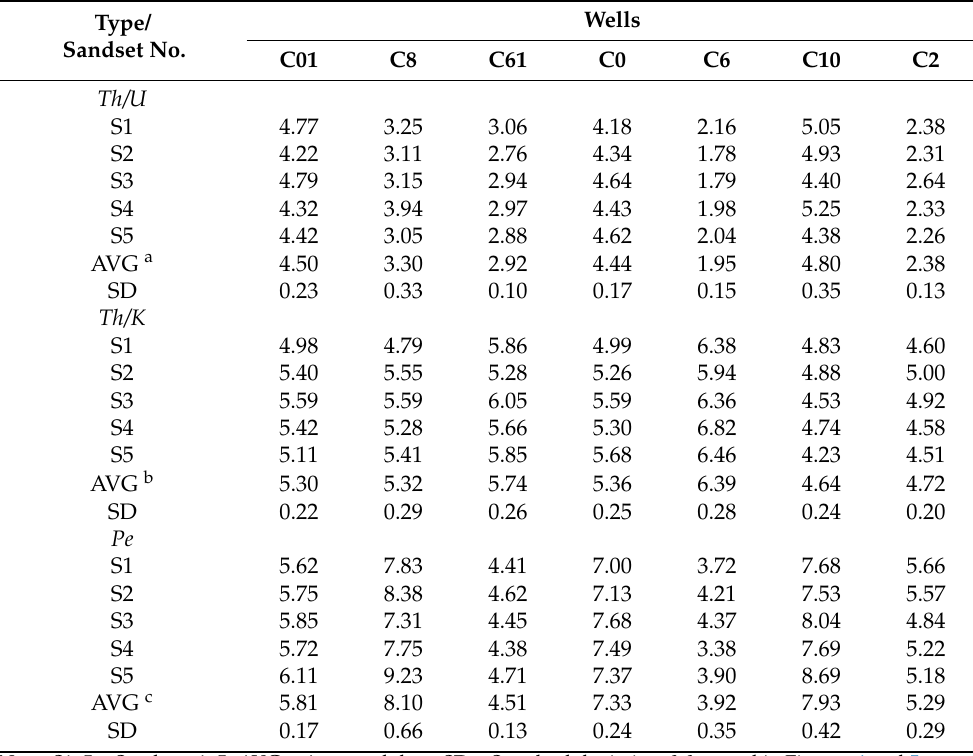
Table 1. Th/U,Th/K,andPederivedfromsevenwellsfromtheEs 3L FormationintheChezhendepression. Type/ Sandset No.